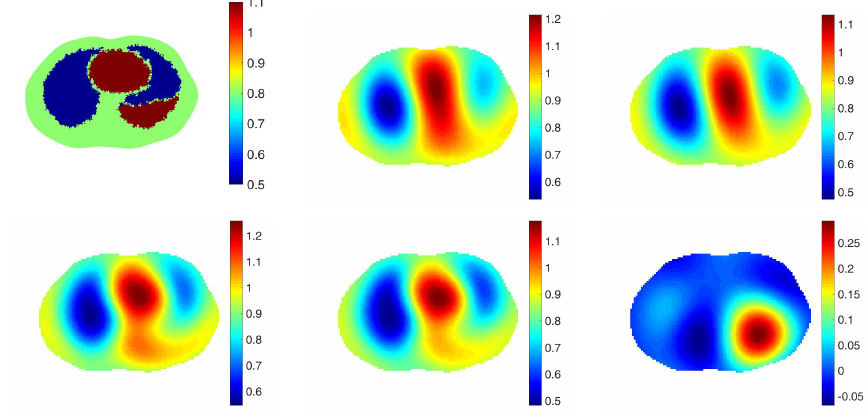
Figure 6. Simulated pleural effusion. From left: The true conductivity distribution, reconstruction of γ abs with no prior, γ diff with no prior, γ abs pr with the spatial prior, γ diff pr with the spatial prior, a difference image in which the data for the example of healthy heart and lungs in Figure 2 with no pathology is chosen for γ ref . The L2 norms of the differences between those reconstructions and the ground truth are 0.3000, 0.3065, 0.2966 and 0.3029 in